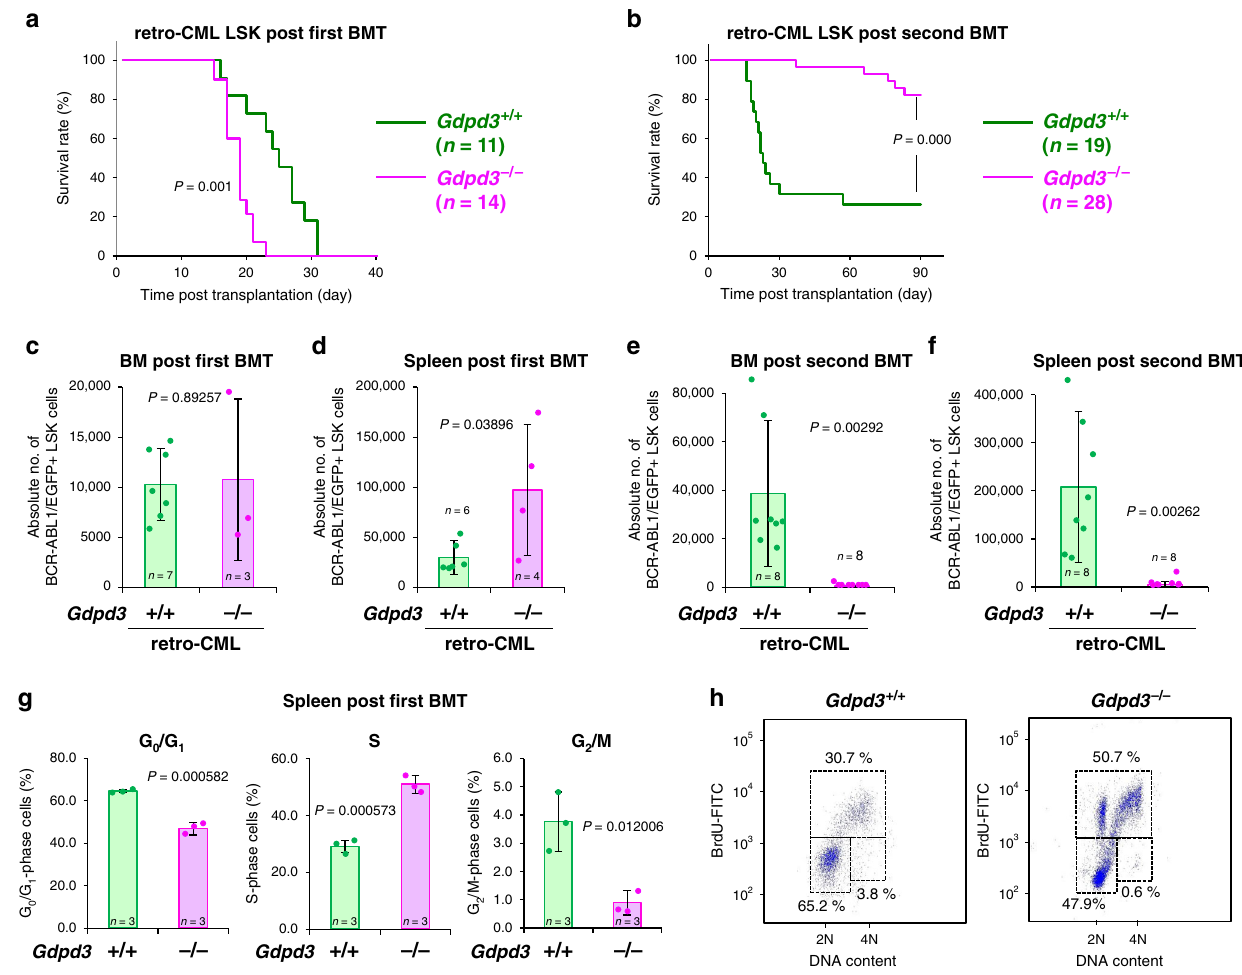
Fig. 2 Gdpd3 maintains the self-renewal capacity of CML stem cells in vivo. a Survival rates of retro-CML-affected mice in a primary BMT experiment that received BCR-ABL1/EGFP-transduced LSK cells from either Gdpd3 + / + mice (one male, one female) or Gdpd3 − / − mice (two females). Results shown are cumulative data obtained from two biologically independent experiments ( P -value, Log-rank non-parametric test). b The survival rate of